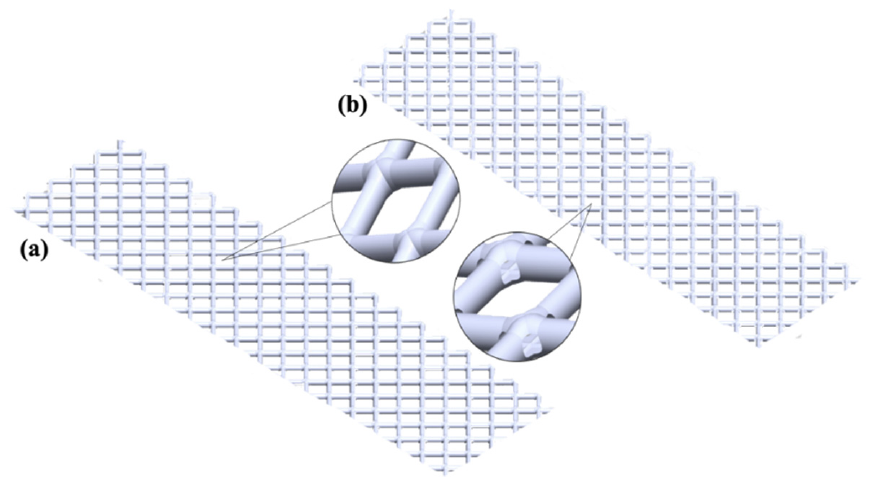
Figure 1. CAD models for ( a ) standard spacer and ( b ) hole-type